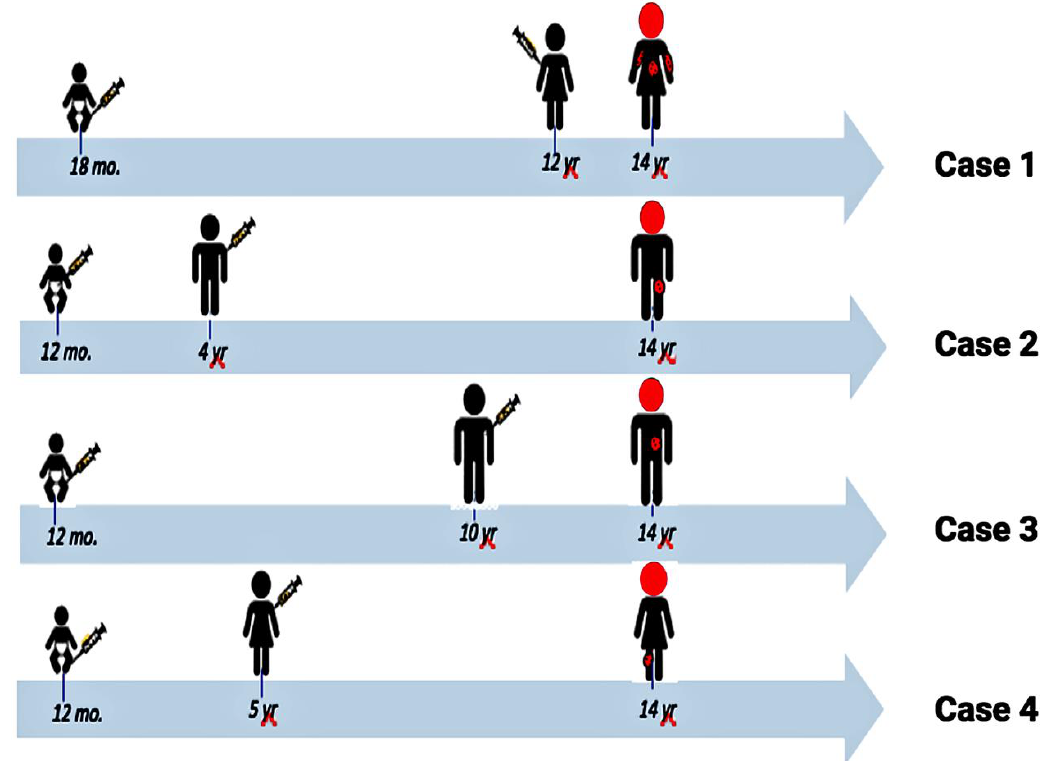
Figure 8. Similarities among the four twice-immunized adolescents who developed varicella vaccine meningitis. All four were given their first varicella vaccination between 12–18 months of age. All four manifested herpes zoster with meningitis at the age of 14 years (heads colored red). Thus, there was a pattern between time of first varicella vaccination and onset of meningitis (~13 years). Data from reference [1].